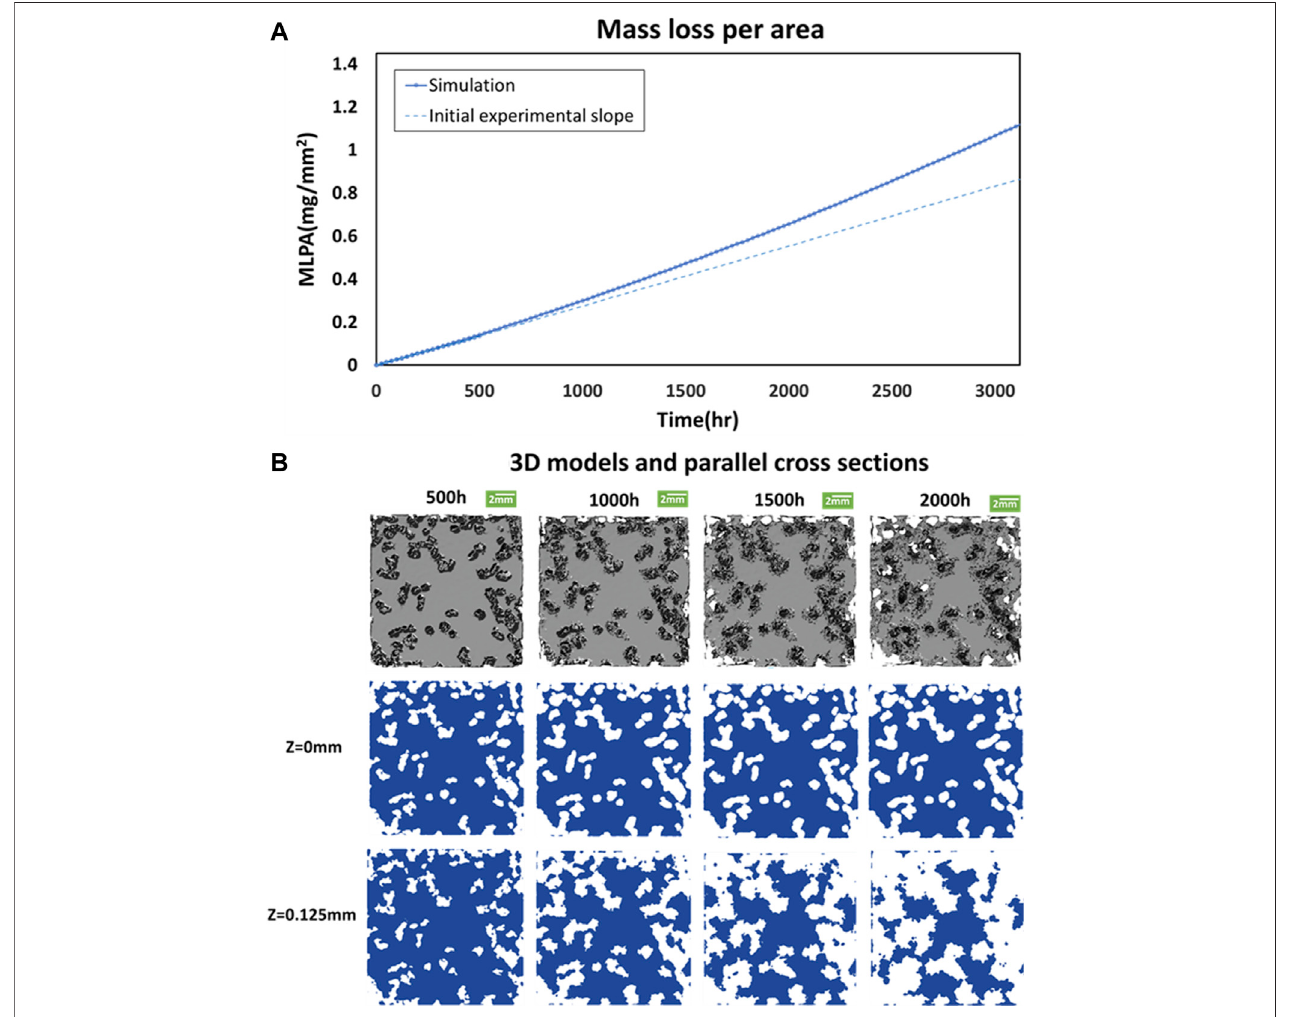
FIGURE4| Long-termpredictions. (A) Masslossperareaofthesimulationmodelcomparestotheinitialexperimentalslopeatdifferentcorrosiontimesinthelong- term. (B) 3D model and corrosion patterns across two parallel cross-sections at z = 0, and 0.125 mm at T = 500, 1,000, 1,500, and 2,000 h, respectively.